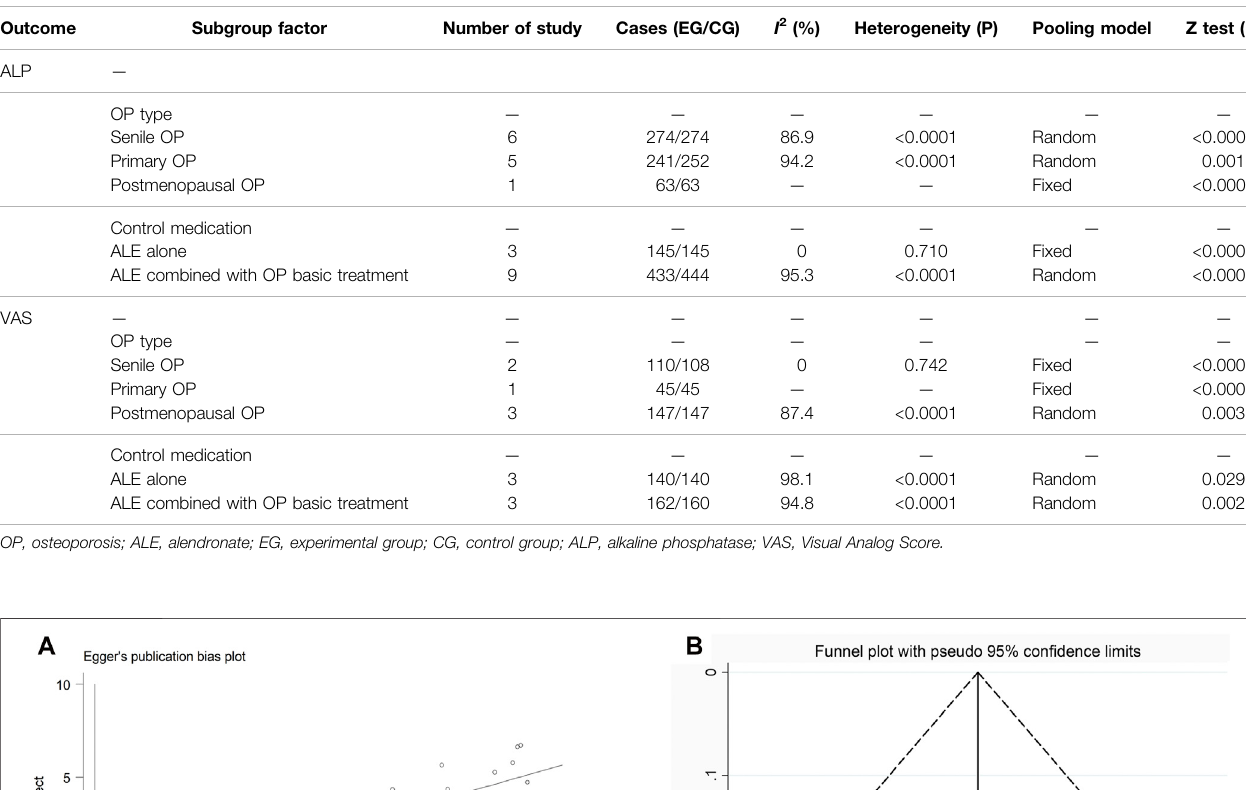
TABLE 3 | Subgroup analysis.